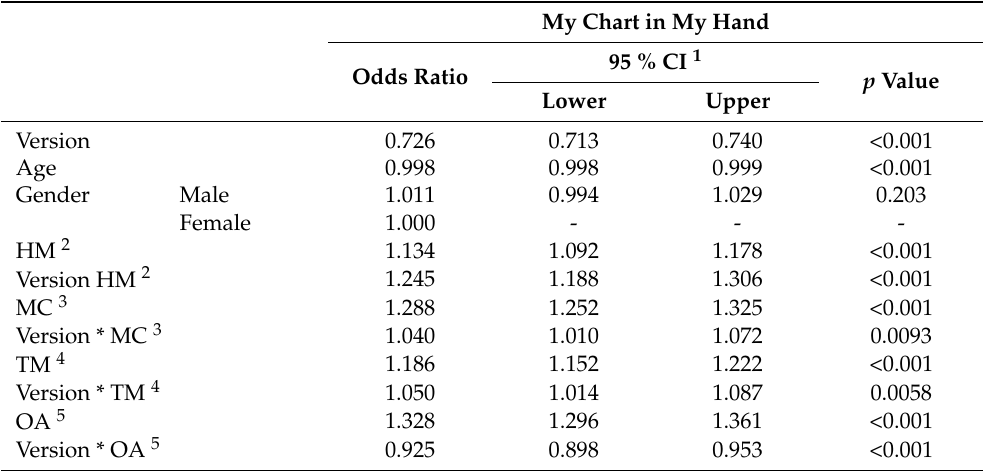
Table 6. Generalized estimating equation analysis including interaction effect according to menu effect and